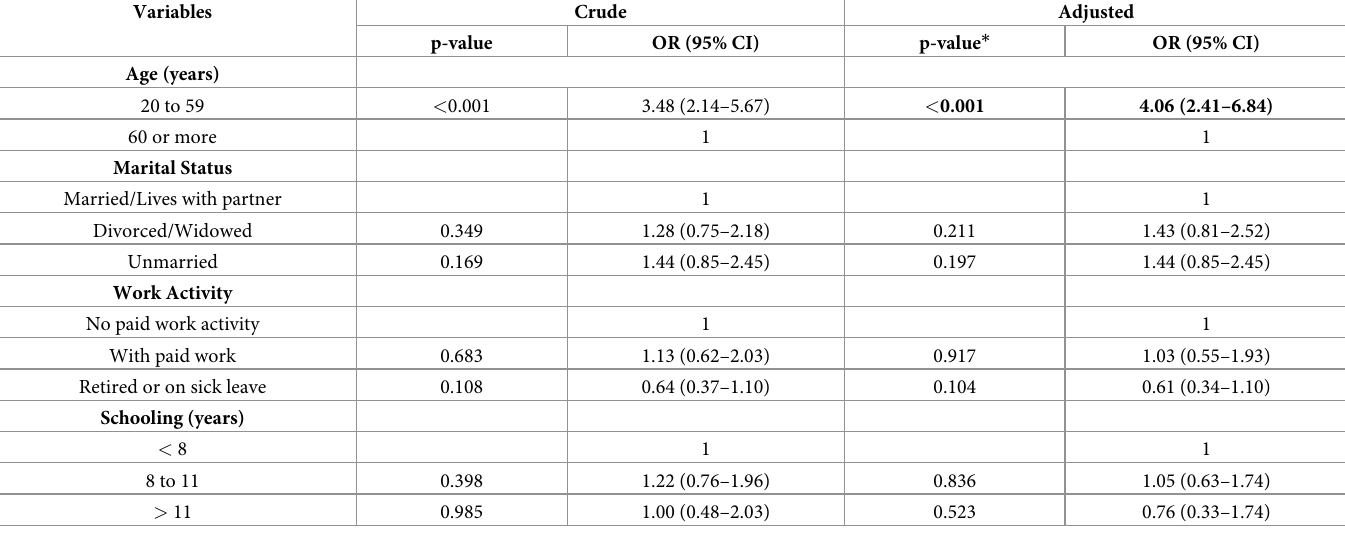
Table 3. Binary logistic regression between associated variables in the bivariate analysis and the outcome.